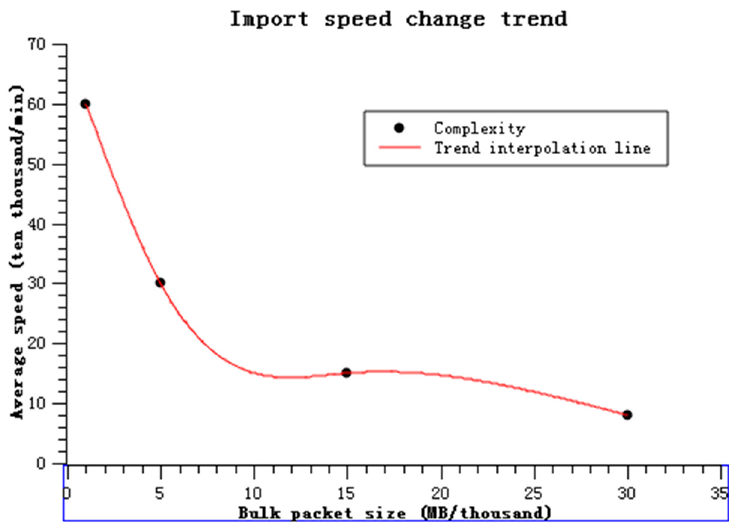
Figure 16. Trend interpolation line. As the size of the packet increases and the complexity of the features increases, the import speed will decrease significantly, and a slow decay rate will be maintained at an inflection